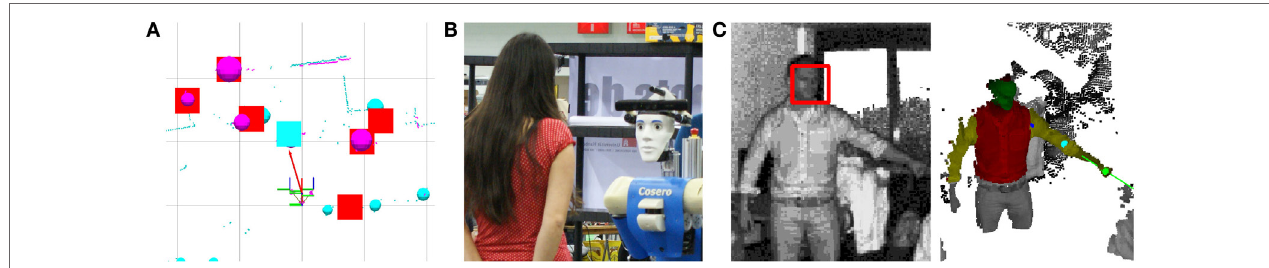
FIgURe 12 | person perception . (A) Persons are detected as legs (cyan spheres) and torsos (magenta spheres) in two horizontal laser range scans (cyan and magenta dots, Droeschel et al., 2011). Detections are fused in a multi-hypothesis tracker (red and cyan boxes). Faces are detected with a camera mounted on a pan-tilt unit. We validate tracks as persons (cyan box) when they are closest to the robot and match the line-of-sight toward a face (red arrow). (B) Enrollment of a new face. (c) Gesture recognition (Droeschel et al., 2011). Faces are detected in the amplitude image. 3D point cloud with the resulting head, upper body, and arm segments (green, red, and yellow) and the locations of the hand, elbow, and shoulder (green, light blue, and blue